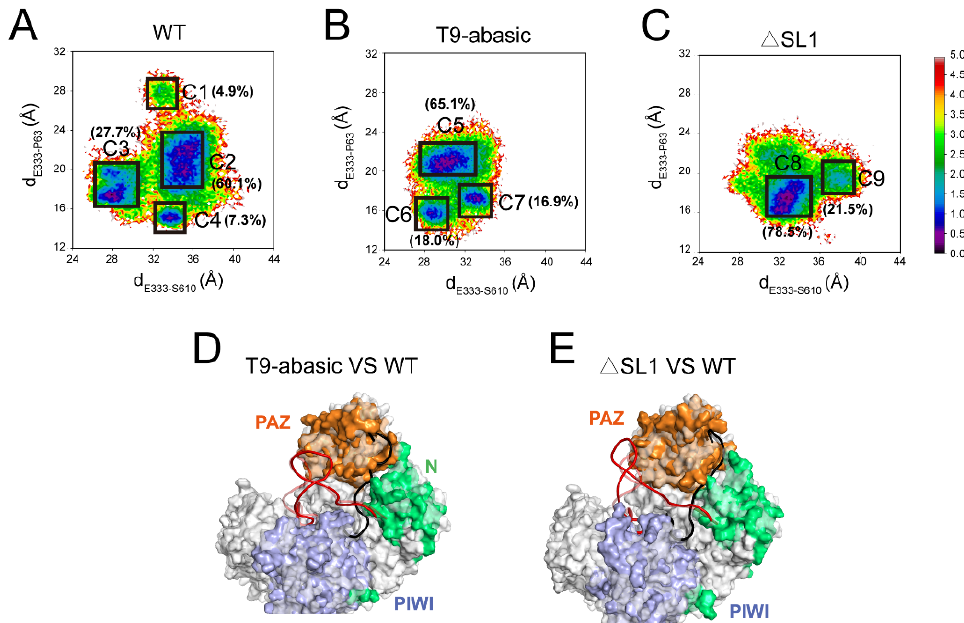
Figure 4. The Ago2 protein adopted a more constrained conformation in the T9-abasic and Δ SL1 systems. ( A – C ) Conformational landscapes which were generated using the dE333–S610 (distance from the E333 C α atom to the P610 C α atom) and dE333–P63 (distance from the E333 C α atom to the P63 C α atom) parameters in the WT system ( A ), the T9-abasic system ( B ) and the Δ SL1 system ( C ). Superposition of the dominant conformations from the T9-abasic system ( D ) and the Δ SL1 system ( E ) to the WT system (transparency), respectively.